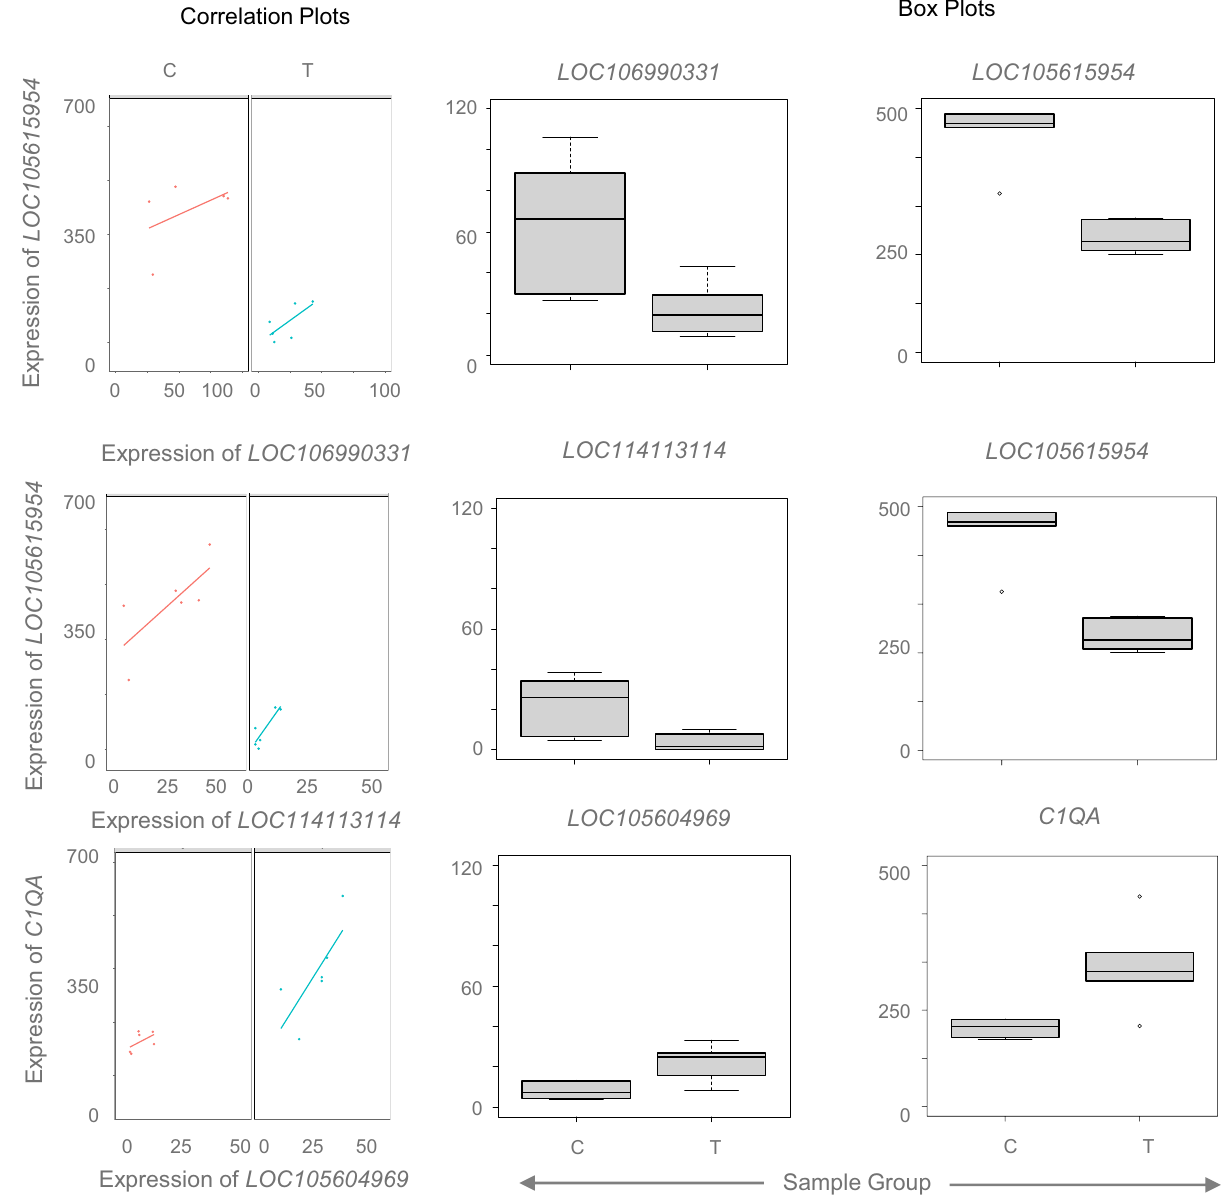
Figure 8. Correlation plots and average expression values for coding and lncRNA in Prenatal T-treated males. Box plots representing the average normalized counts for lncRNA and mRNA pair that showed significant correlation are shown in the right two columns. The treatment groups control (C) or prenatal T (T) are denoted on the X-axis and the average normalized counts on the Y-axis. On the left is the representation for the correlation between the corresponding lncRNA-mRNA pair represented in orange lines for the controls and in green lines for prenatal T-treated